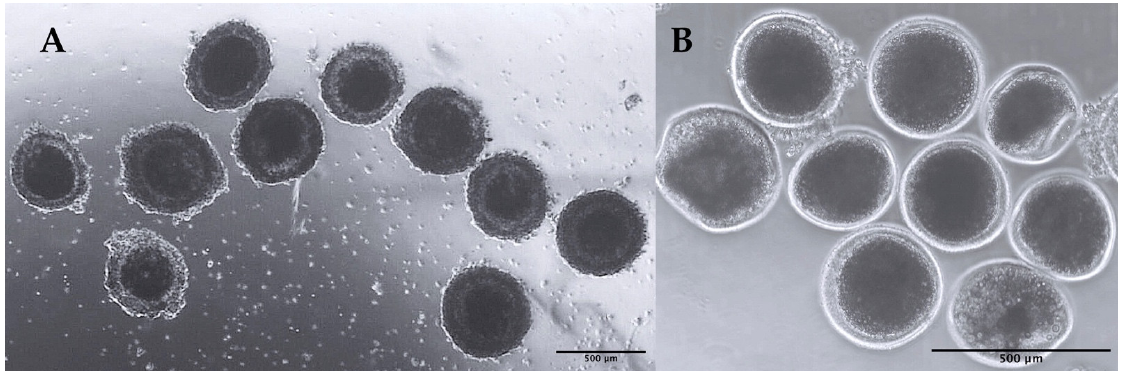
Figure 2. Images of immature European mink oocytes. ( A ) Grade I and II from a specimen found dead on 11 January 2017. ( B ) Grade 4 specimen found dead on 7 July 2016. Flow cytometry was used to assess some characteristic cell surface markers to further characterize all eight types of emMSCs (Figures 3 and S1). Except for emOA-MSC, all cell lines examined expressed high levels of MSC-specific markers (CD44, CD9, CD29, and CD90). emOA-MSC expressed high levels of CD44, CD9, and CD29 markers but was neg- ative for CD90. In terms of pluripotency marker expression, POU5F1 was expressed in all emMSCs except emBM-MSC, which did not express any of the pluripotency markers analyzed (POU5F1, SOX2, and STRO1). The SOX2 marker was found exclusively in the three emMSCs associated with female reproductive tissues. Figure 3. Analysis by flow cytometry of the expression levels of cell surface markers CD29, CD90, CD9, CD44, SOX2, STRO1, and POU5F1 in emDS-MSC, emO-MSC, emOM-MSC, emT-MSC,